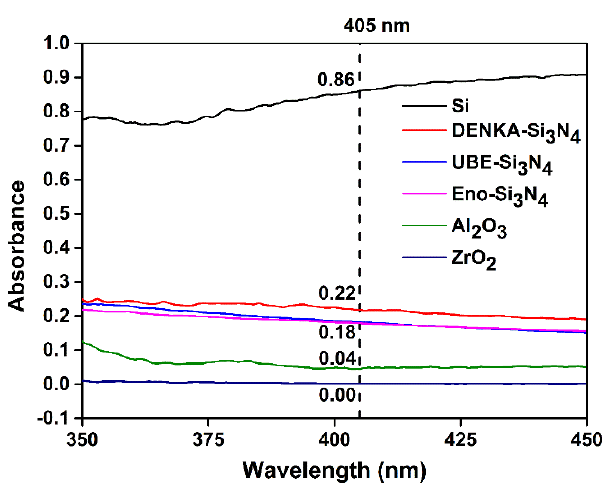
Figure 6. The absorbance of raw powders.